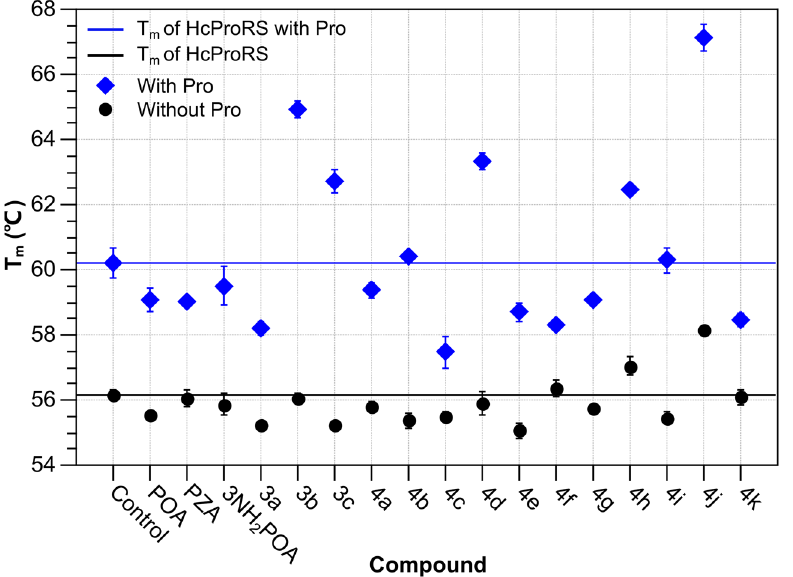
Figure 3. Evaluation of compound binding by a fluorescence-based thermal shift assay. T m values of HcProRS were measured by incubating with 100 µM of compound in the absence (black circles) or presence (blue diamonds) of 1 mM Pro. The control samples of the two separate experiments correspond to the T m of HcProRS with vehicle in the absence or presence of 1 mM Pro, respectively. The black and blue lines correspond to the T m values of the respective control samples. Each measurement was performed in triplicate with standard errors shown.